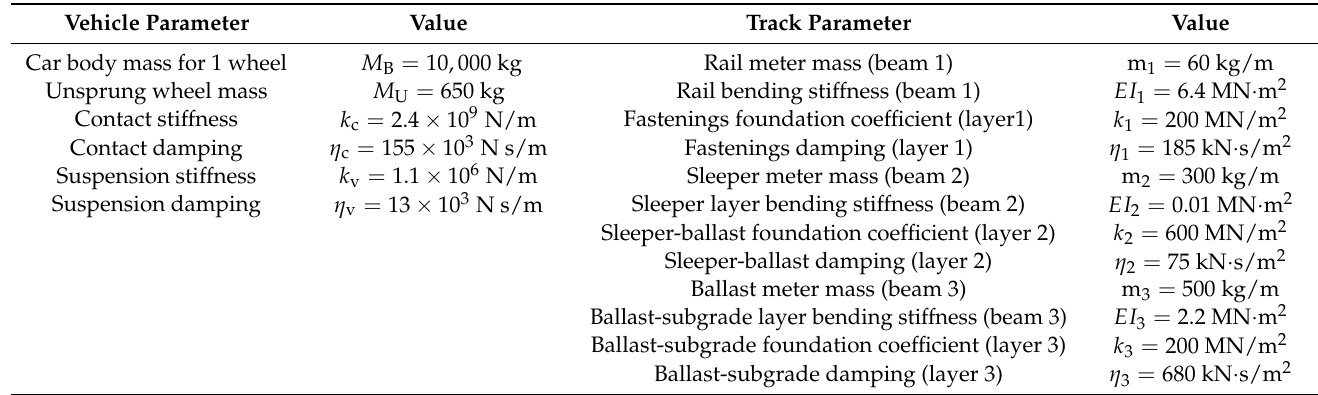
Table 1. Parameters of the dynamic model.